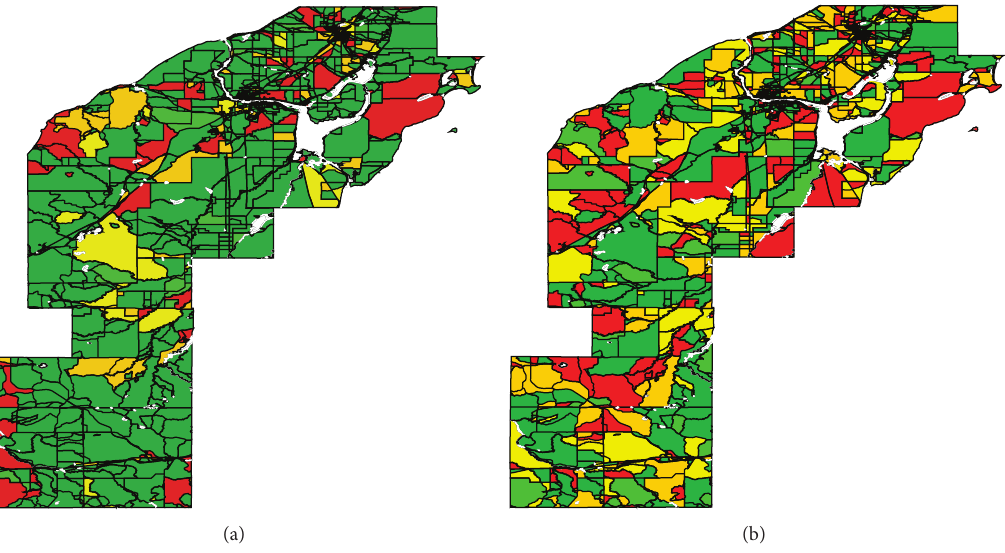
Figure 7: (a) is a representative map of Houghton County showing the spatial clustering and higher average forest age of simulations with high social influence. (b) is a representative map showing the lack of spatial clustering and lower average forest age of simulations with low social influence (see Figure 5 for a comparison of spatial statistics between these two maps and see Figure 6 for a comparison of average forest age). Red: clear-cut; yellow: young forest; green: old growth; white: water.